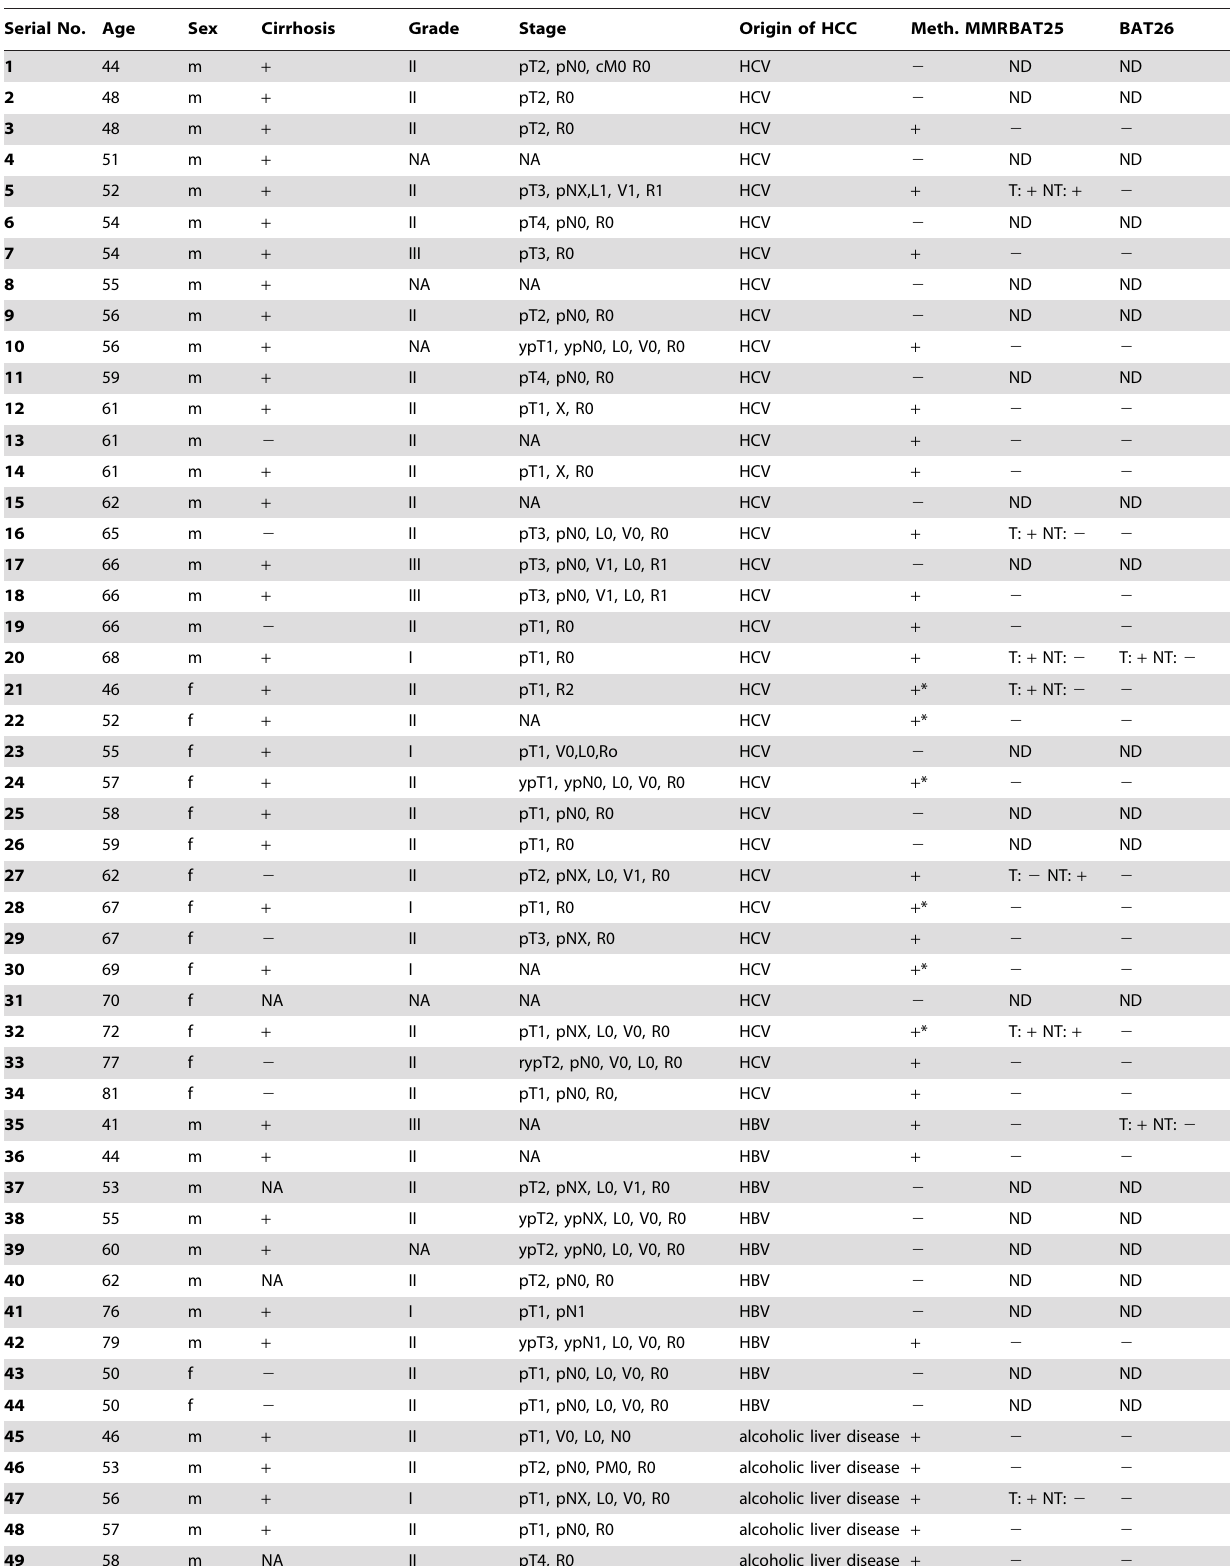
Table 1. Clinical feature of the studied